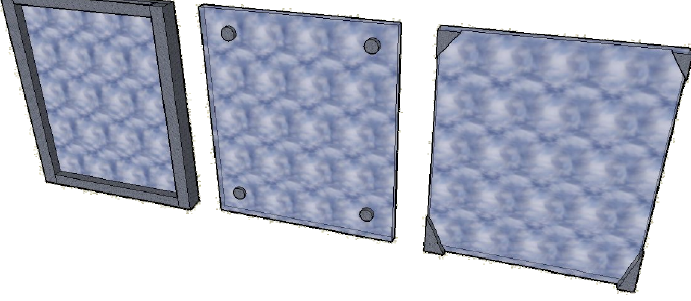
Figure.2: Examples for different fixing types for laminated glass panels.